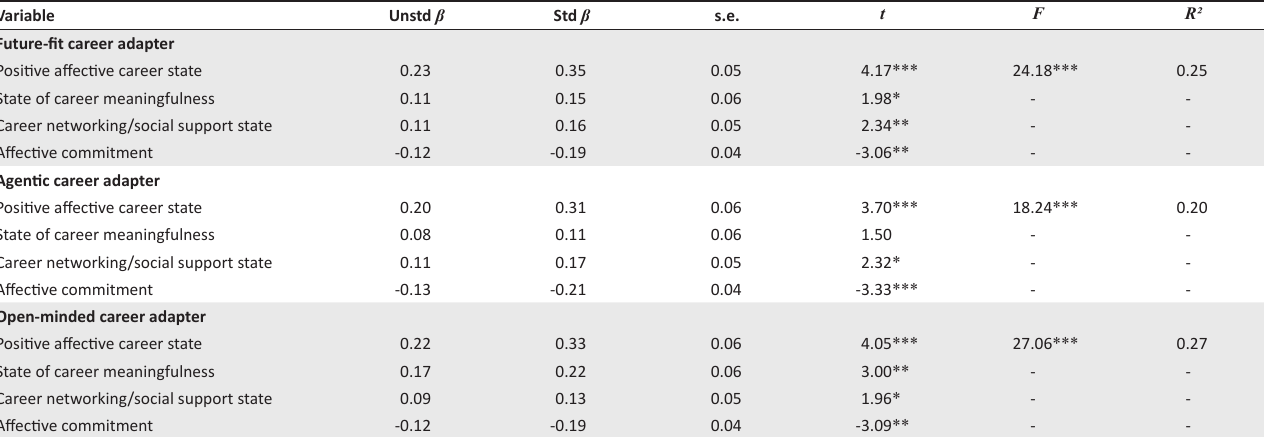
TABLE 3: Regression of career wellbeing and affective commitment upon the career agility facet combinations.